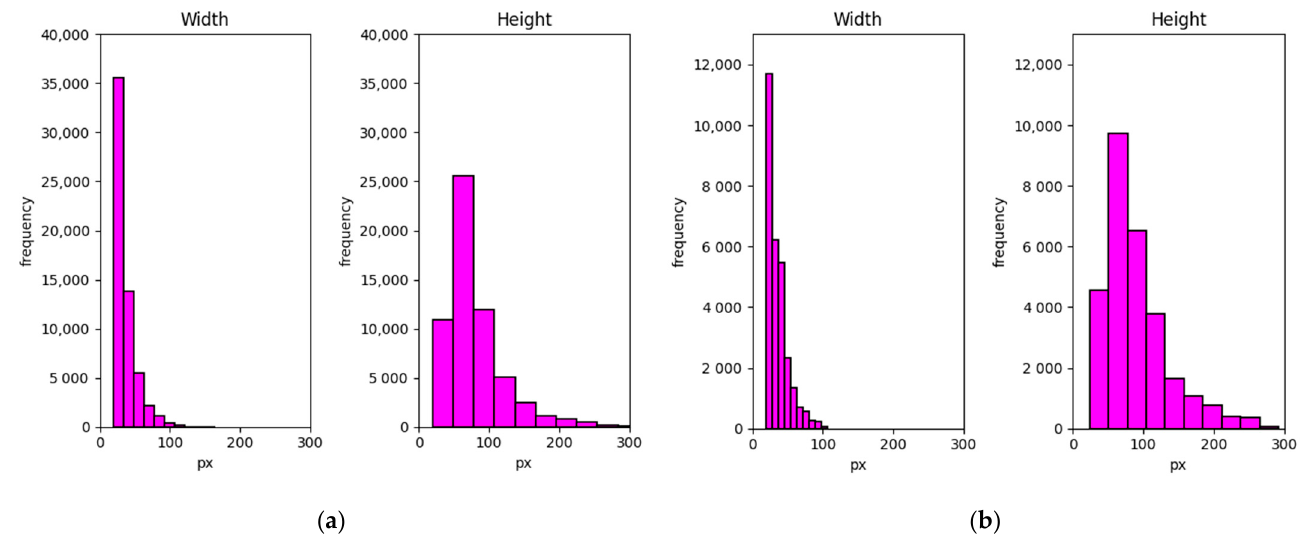
Figure 3. Pedestrian scale distribution in ( a ) daytime and ( b ) nighttime. To accomplish this proposal, additional feature output layers are added. In the original YOLO v3, feature output layers are attached in the 3rd, 4th, and 5th residual blocks. Each feature output layer is responsible for small objects until large objects in ascending order. As a result, to enhance the capability of detecting smaller objects, feature output layers are added from the 2nd residual. The additional feature output layer is the same as the feature output layer in the 3rd and the 4th residual block. The 5th residual block’s feature layer contains a Spatial Pyramid Pooling (SPP) structure. As an illustration, Figure 4 shows the architecture of the optimized YOLO v3. The default image size is 416 × 416. The green cell indicates the image size reduction of the 416 × 416 size. The deep neural network in Figure 4 is named as